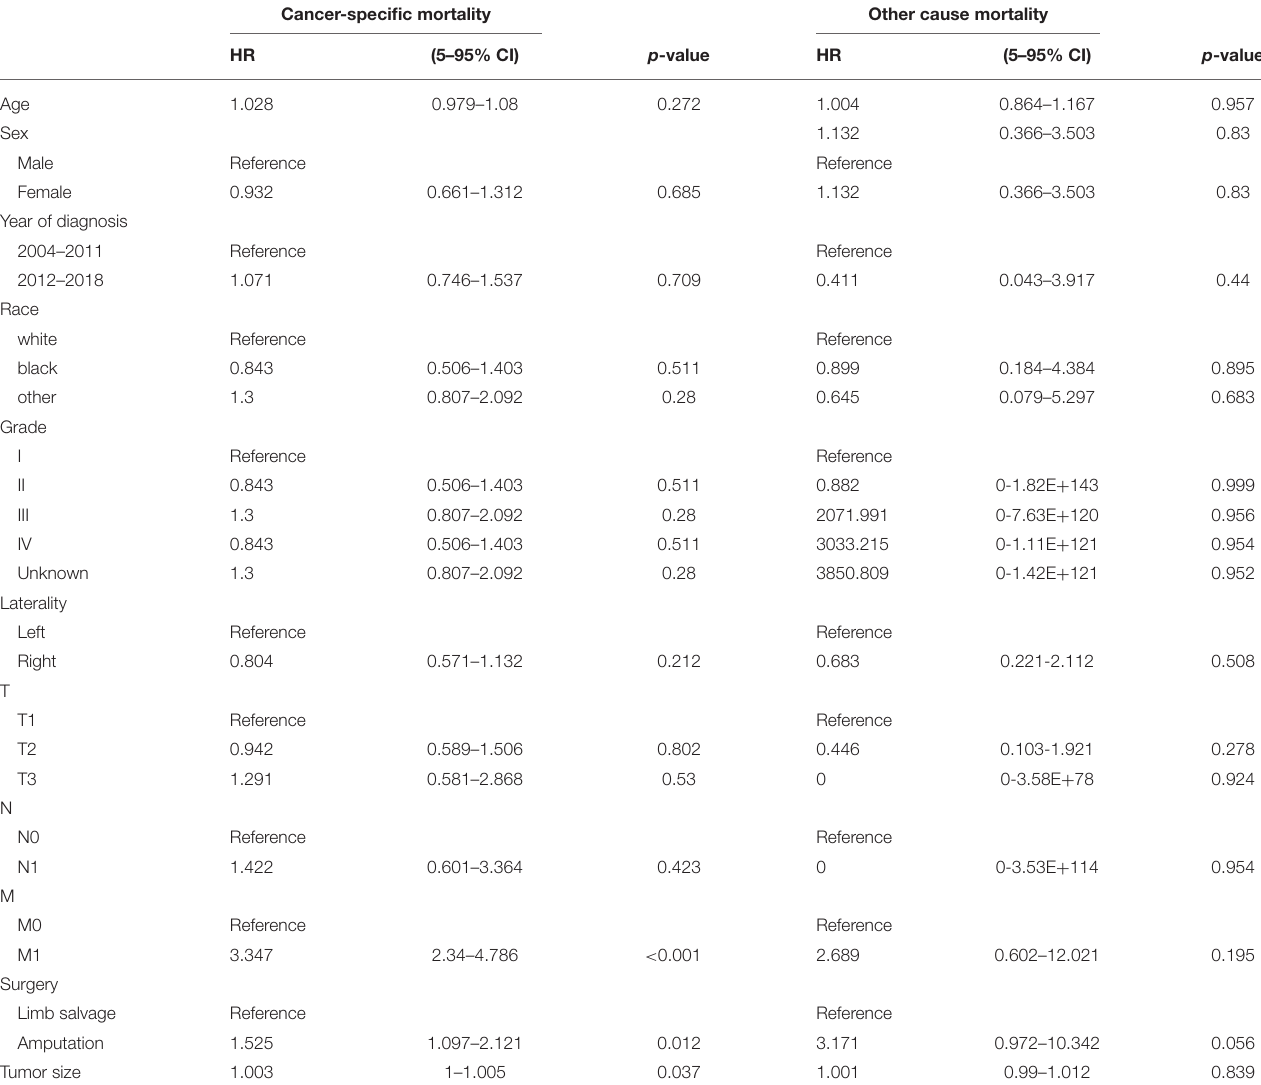
TABLE 3 | Propensity score-adjusted multivariate Cox regression models predict cancer-specific mortality and other causes mortality in pediatric osteosarcoma